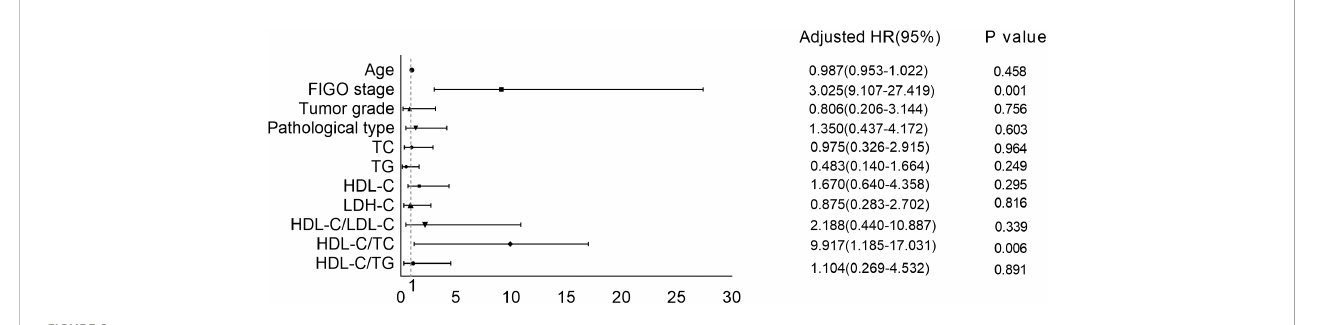
FIGURE 2 Correction between serum lipid levels as well as other clinical features and chemoresistance.